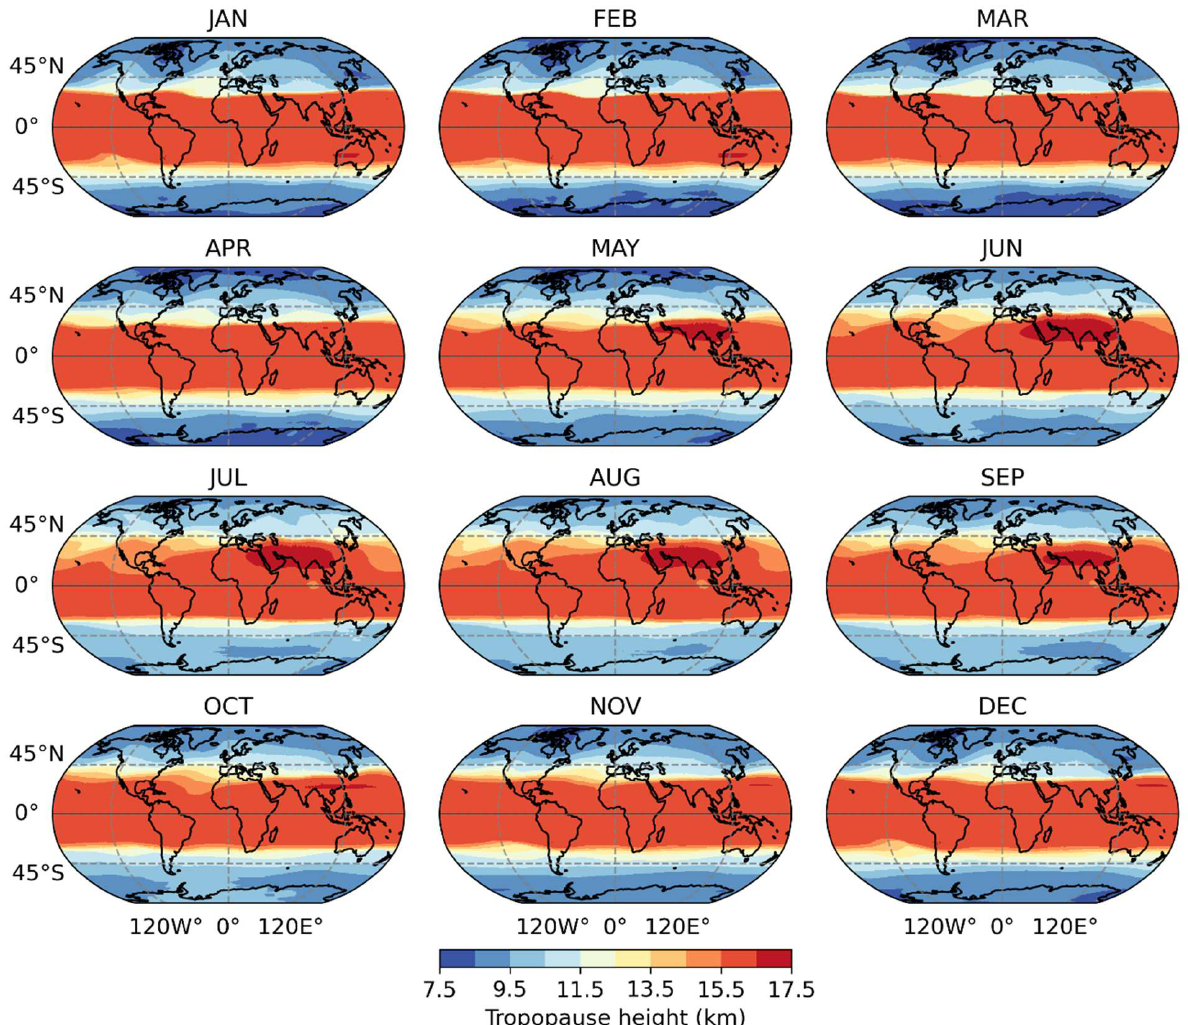
Figure 2. The combined mean tropopauses for each month, taking the 3.5 PVU surface as an example. Since the NH seasonal cycle reveals different characteristics compared to the SH seasonal cycle, mainly during the summer NH months, an analysis of the annual cycle spatial patterns can be helpful to distinct spatial trends between both hemispheres. So, we computed the mean tropopause anomalies for each month (using the 3.5 PVU surface as reference). Figure 3 shows the tropopause anomaly zonal profiles for each month. In the winter NH months, negative anomalies (lower tropopauses) were present in the subtropics zone, showing a well-defined longitudinal band, close to the location of the subtropical jet streams, in the transition between the Hadley and Ferrel cells, that could also be observed in the SH with positive anomalies (higher tropopauses). Nevertheless, a positive anomaly band could be observed in the NH summer months, moving some degrees of latitude, mainly over land, toward the pole. The meridional and seasonal variations in the mean zonal tropopause (and tropopause temperature) were characterized by a minimum and maximum during the NH winter and summer months, respectively, associated with the global jet stream structure. Furthermore, the tropopause pattern variability was positively correlated with the corresponding tropospheric temperature patterns (not shown). Other studies showed similar results, e.g., [10,17,43– 45].